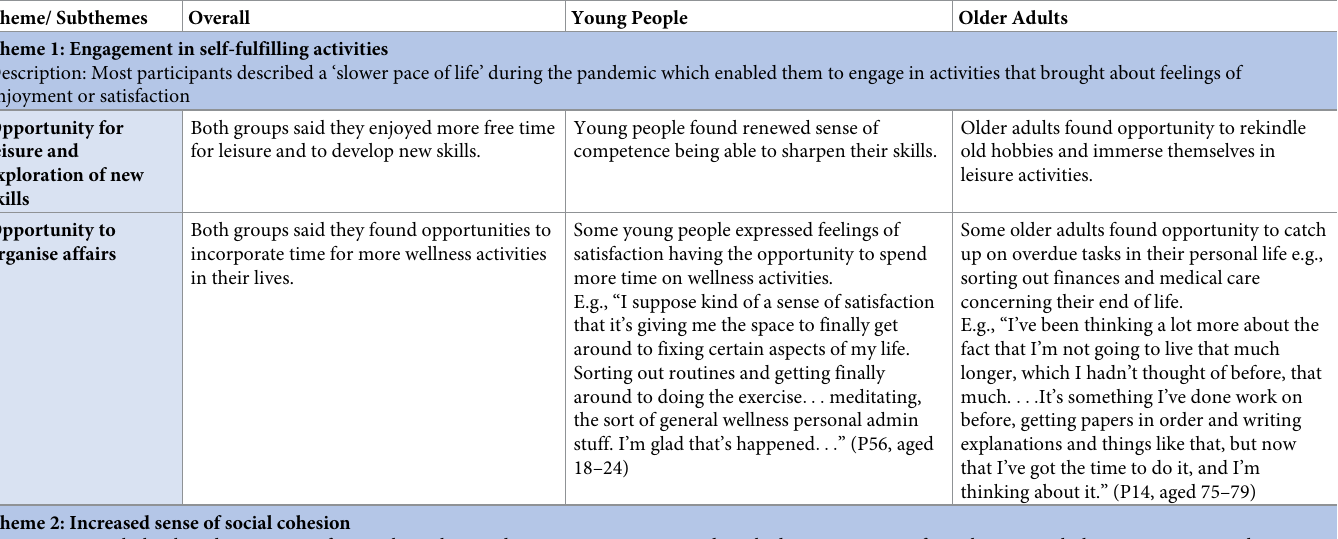
Table 2. Themes and subthemes on positive psychological experiences, with summary of similarities and differences between young and older participants. Theme/